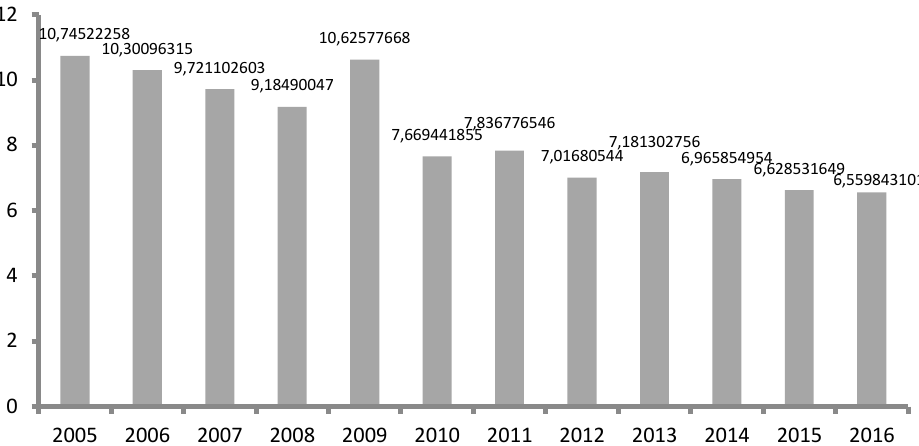
Figure 1: Share of logistics services in Ukraine's GDP (in %)